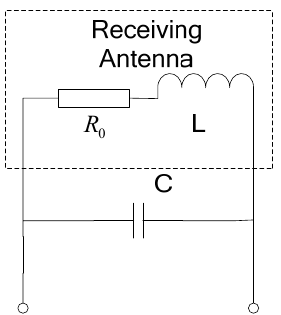
Figure 15. The basic parallel resonant circuit.